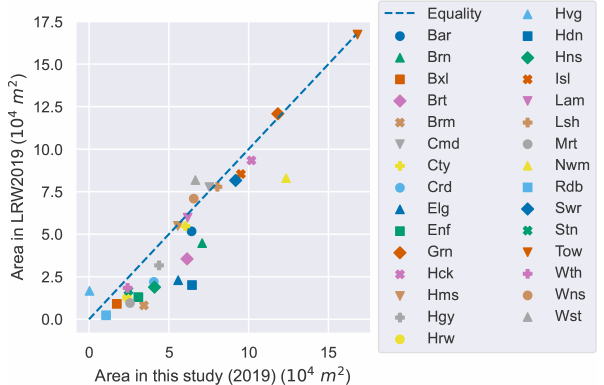
Figure 10. Scatter plot showing estimated green roof area in LADs of Greater London, estimated from Livingroofs Enterprises Ltd (2019) with 2017 imagery to our estimates with 2019